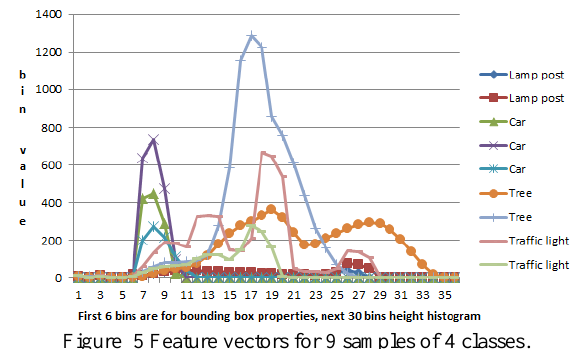
Figure 5 Feature vectors for 9 samples of 4